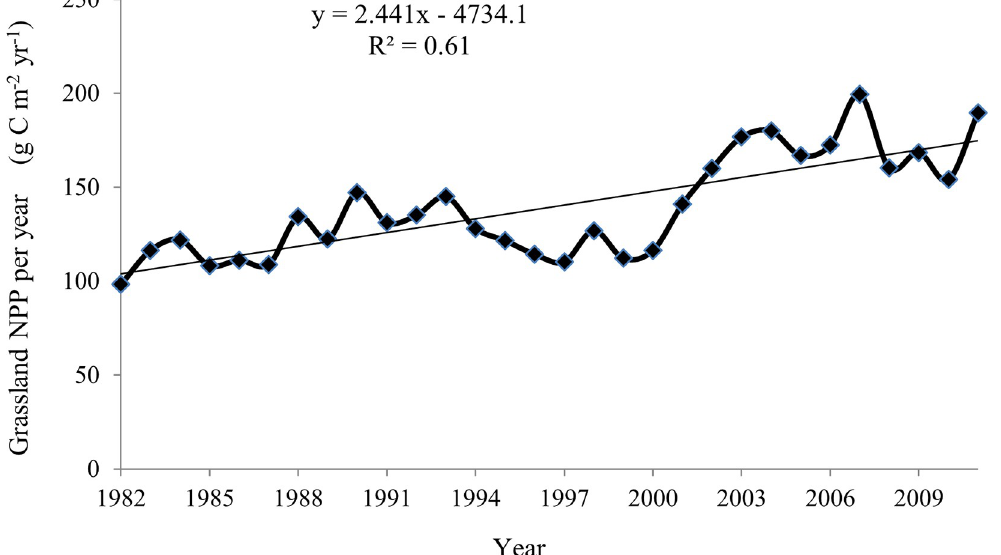
Fig 5. Interannual changes of grassland NPP in Gansu, China from 1982 to